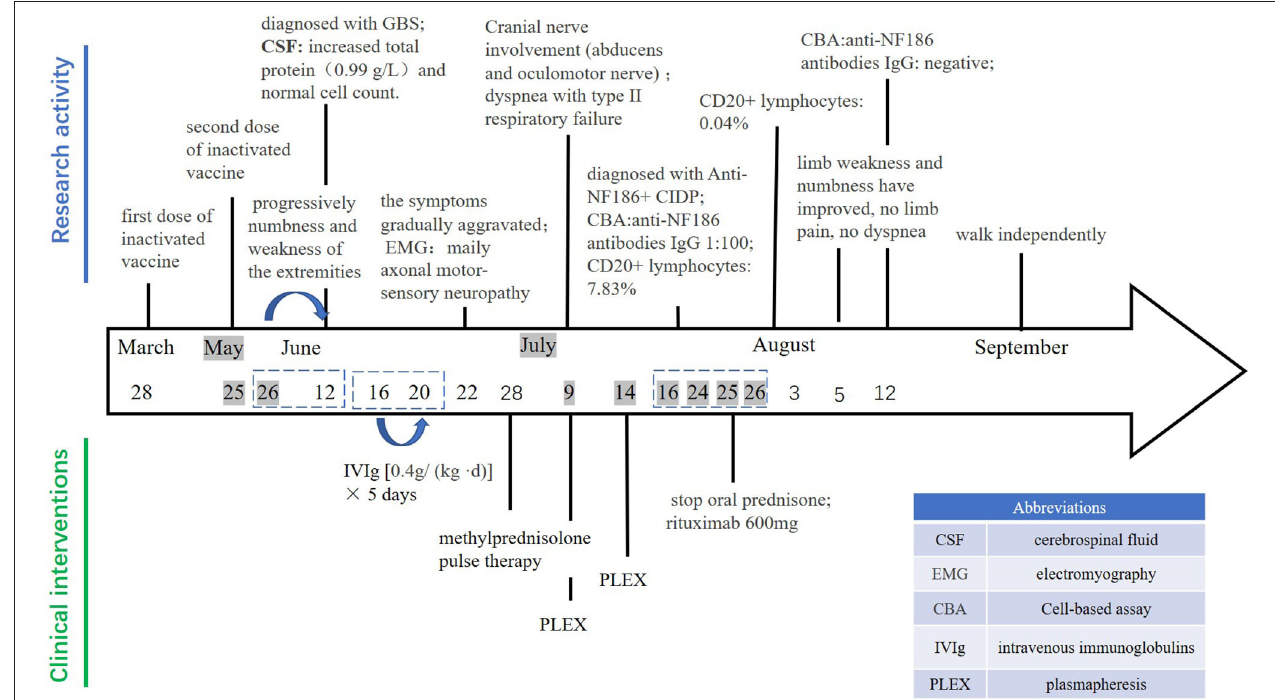
FIGURE 2 | The timeline of clinical